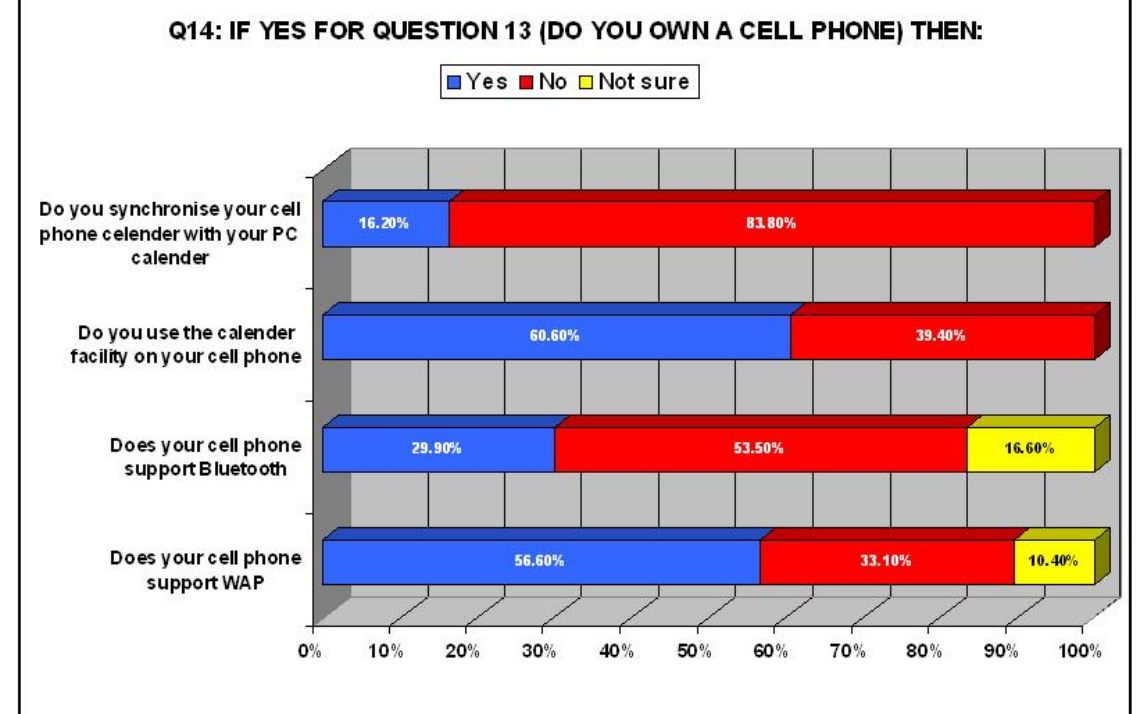
Figure 11 Representation of the responses to Question 14 of the